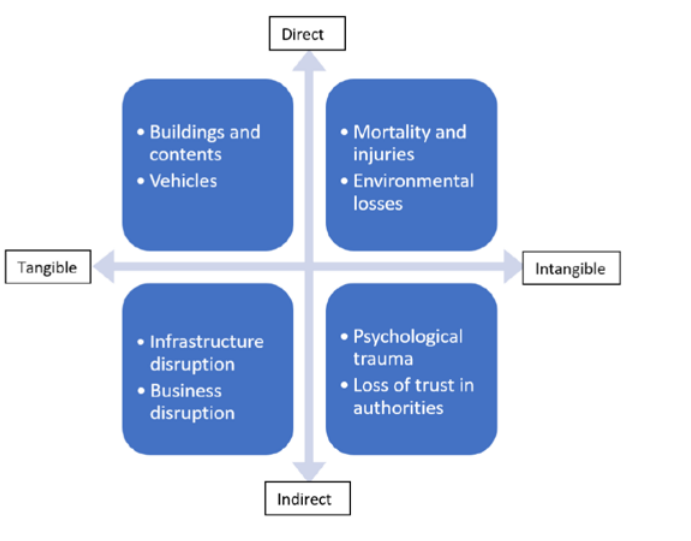
Figure 1. There are direct and indirect impacts of flood damages that are not easily quantified in monetary terms